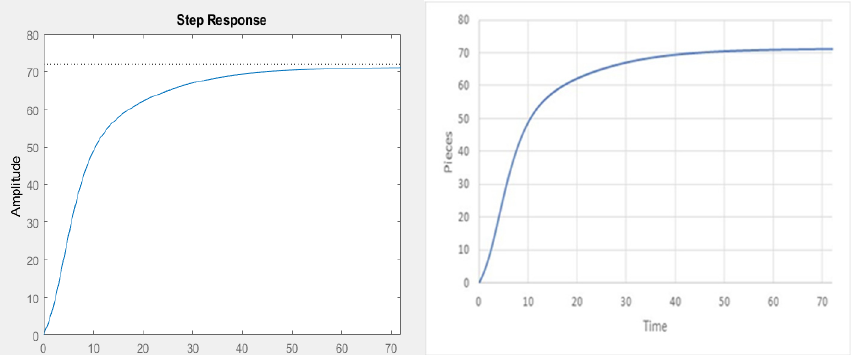
Figure 31. Output at a step input of 72 and the Stella software.